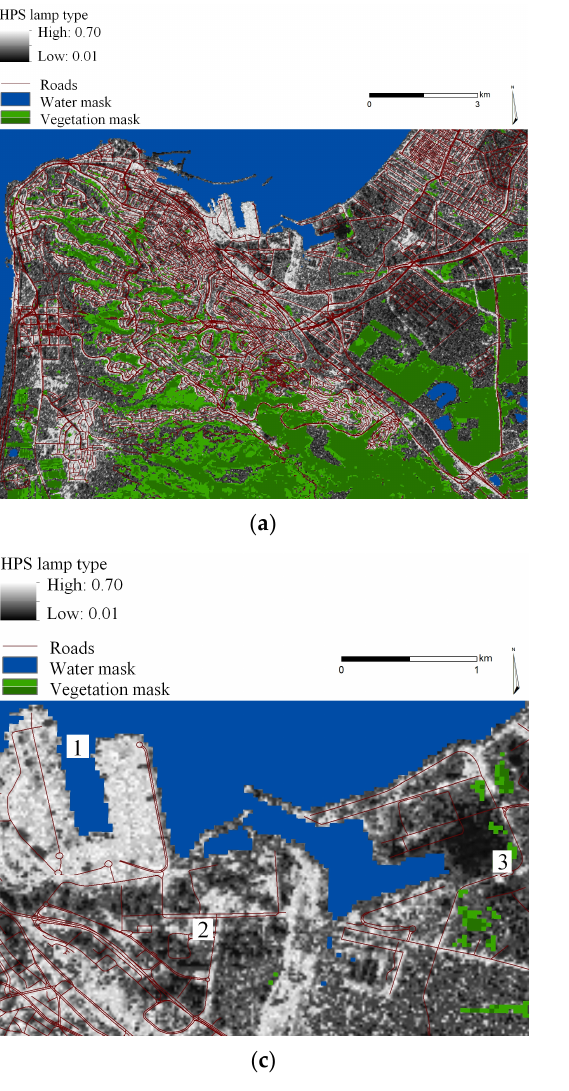
Figure 7. Model-anticipated relative contribution of High-Pressure Sodium ( a , c ) and Metal Halide ( b , d ) lamps in the outdoor lighting in Haifa area ( a , b ) and selected ROIs ( c , d ): “1” = Haifa Bay Area; “2” = Khof Shemen Industrial Zone; “3” = Haifa Airport. Note : Water and vegetation masks (marked, respectively, blue and green) were produced from Landsat 8 OLI/TIRS C2 L2 dataset image (path 174 row 037) acquired on June 8, 2015 [40]. For vegetation mask, normalized difference vegetation index (NDVI) was calculated as NDVI = (Band5 − Band6)/(Band5 + Band6) [41], and levels in 0.22–0.25 and >0.25 diapasons were marked as light and dark green. For the water mask, normalized difference moisture index (NDMI) was calculated as NDMI = (Band5 − Band4)/(Band5 + Band4) [42].